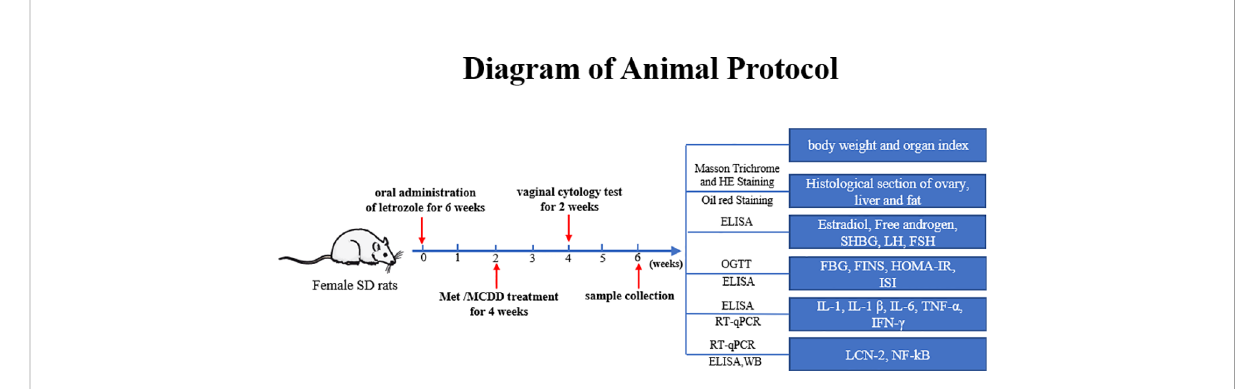
FIGURE 1 Diagram of Animal